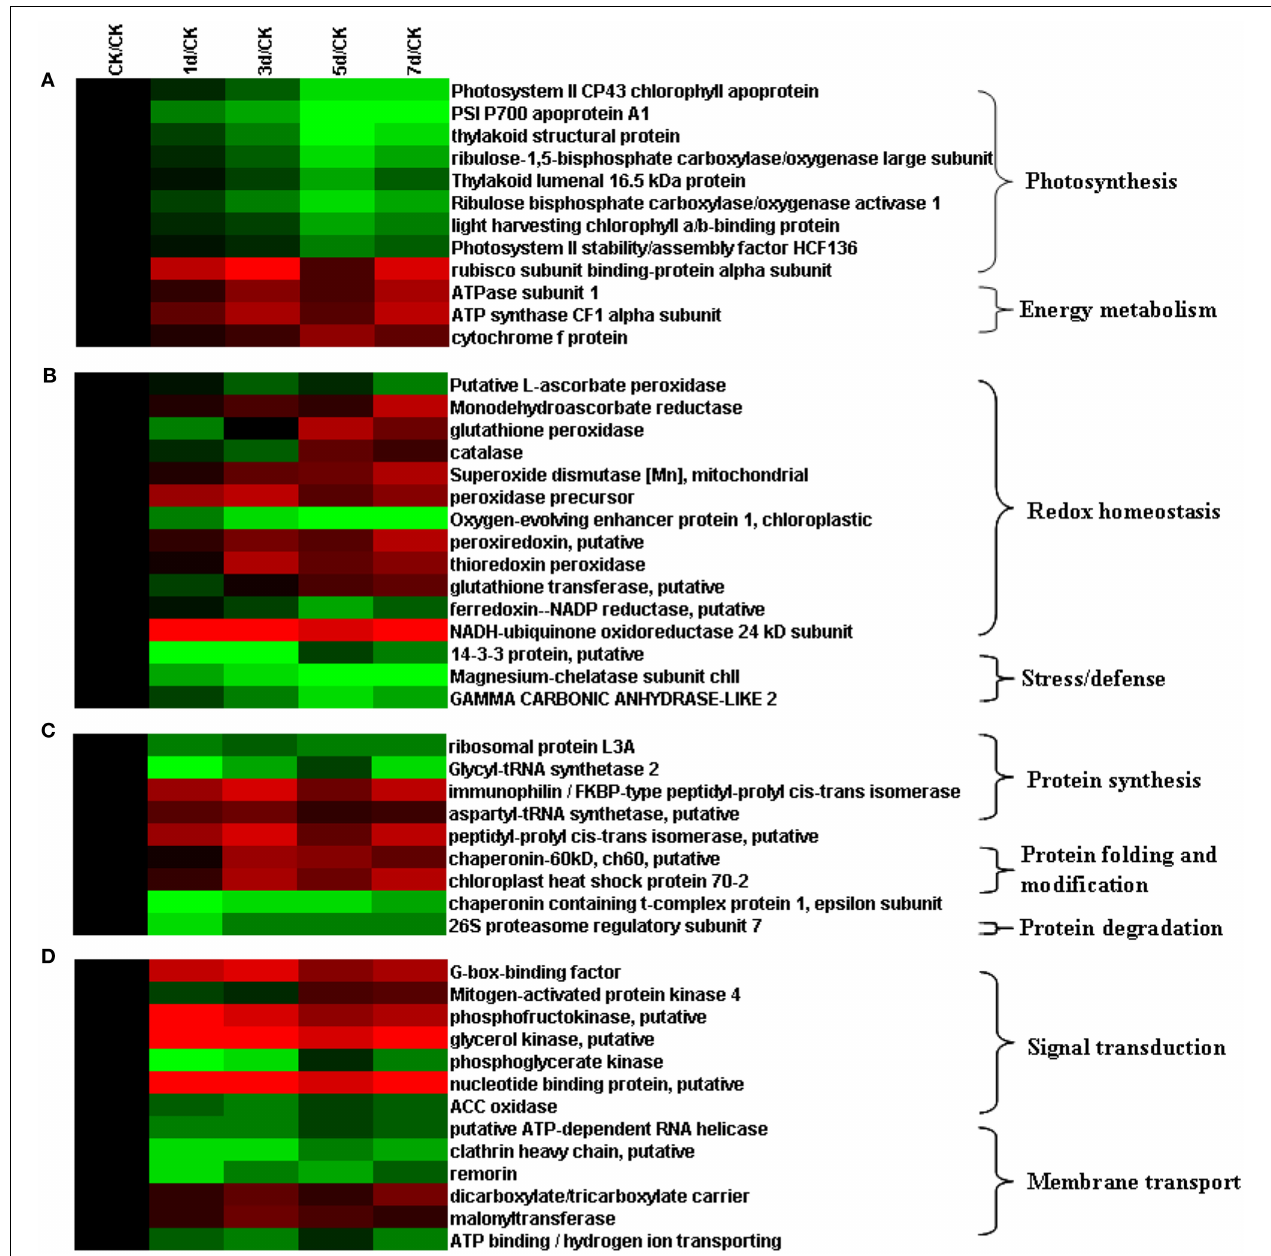
FIGURE 7 | Hierarchical clustering of salinity stress-responsive proteins involved in (A) photosynthesis, (B) antioxidative reactions, (C) protein metabolism, and (D) signal transduction.